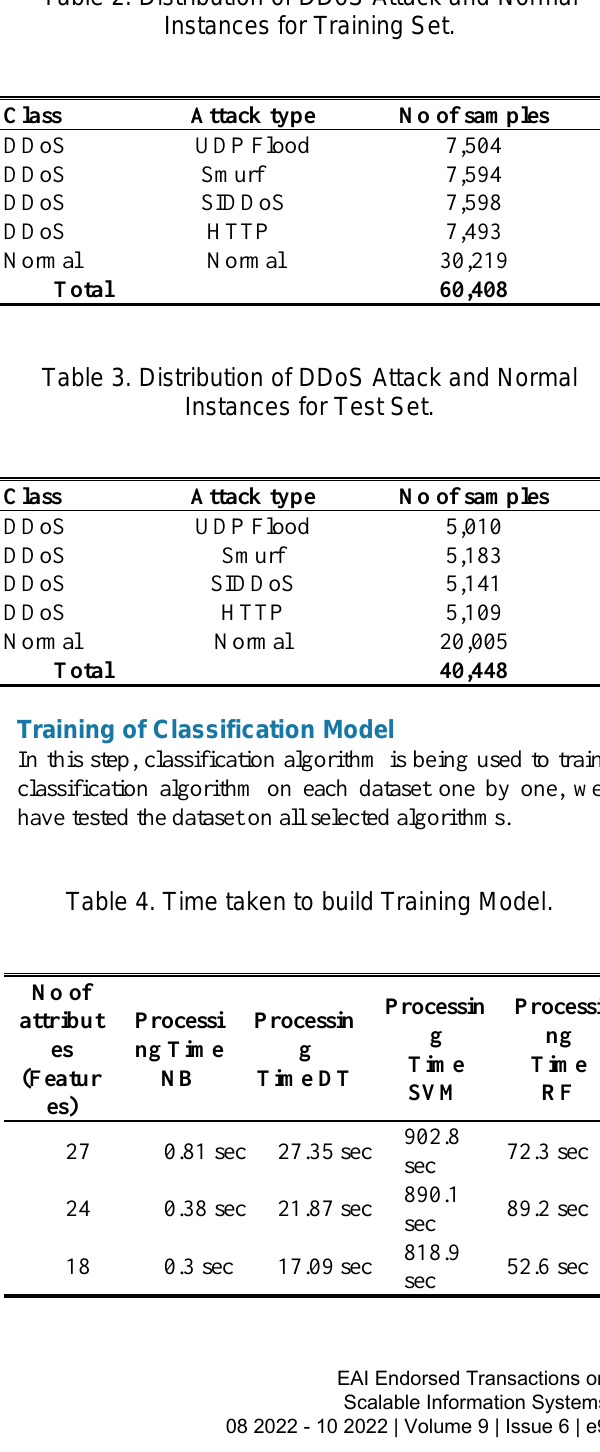
Table 1. Distribution of DDoS Attack and Normal Instances.